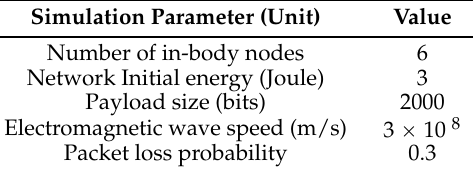
Table 7. Simulation Parameters.